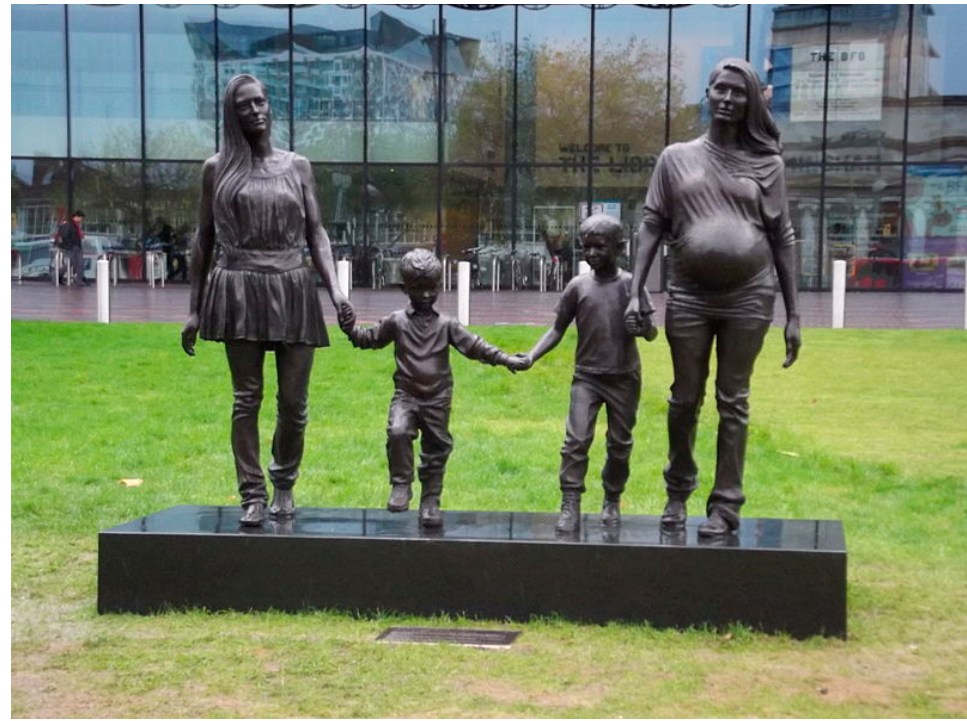
Figure 1. ‘A Real Birmingham Family’, 2014. Source: